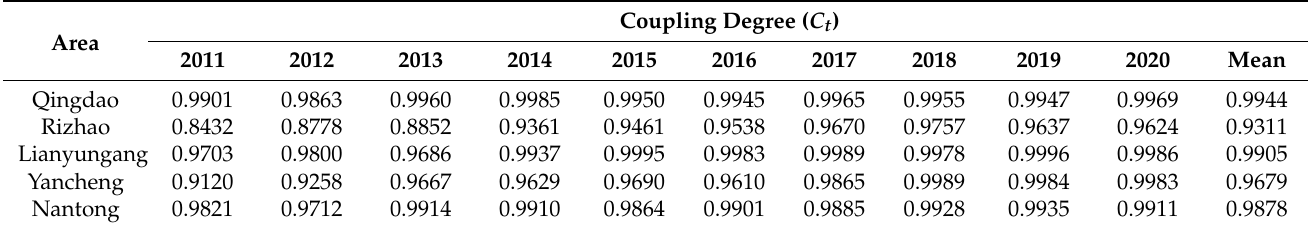
Table 5. The coupling degrees of the cities in the years 2011–2020.